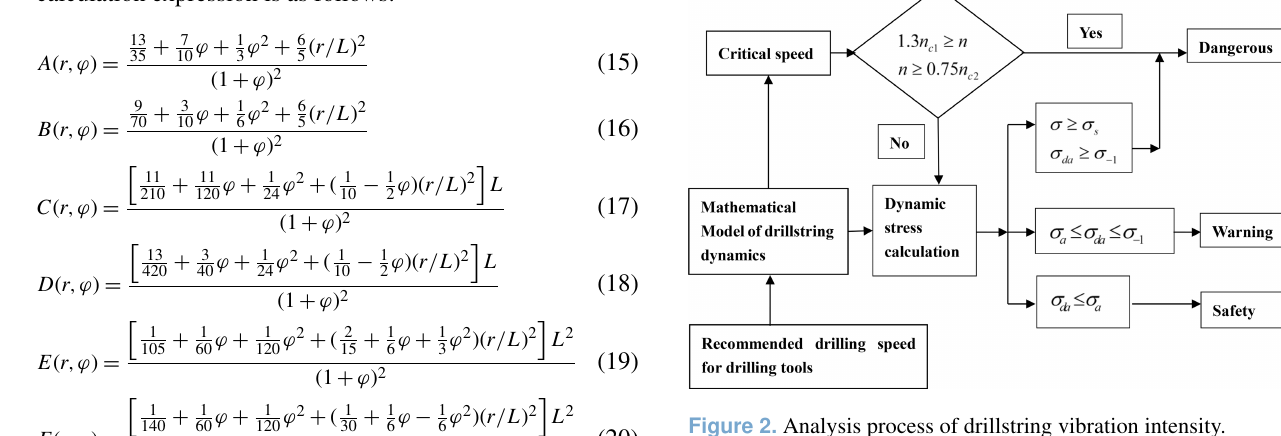
Figure 2. Analysis process of drillstring vibration